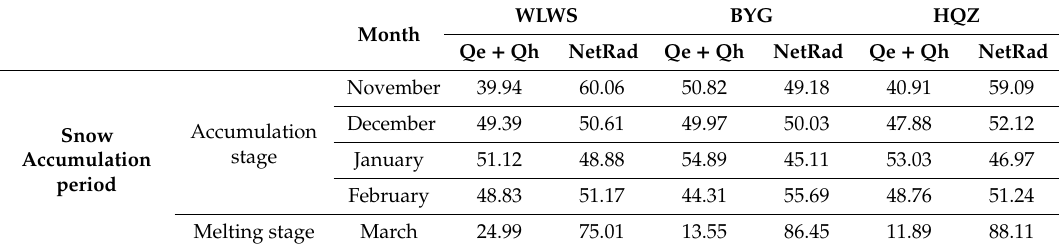
Figure 7. Characteristics of the variations in net radiation, sensible heat flux, latent heat flux, and wind speed at 3-h intervals between 0:00 on 1 November 2014 and 21:00 on 31 March 2015. Table 6. Contribution percentages (%) of the net radiation and net turbulence flux to snow mass loss during the snow accumulation period.